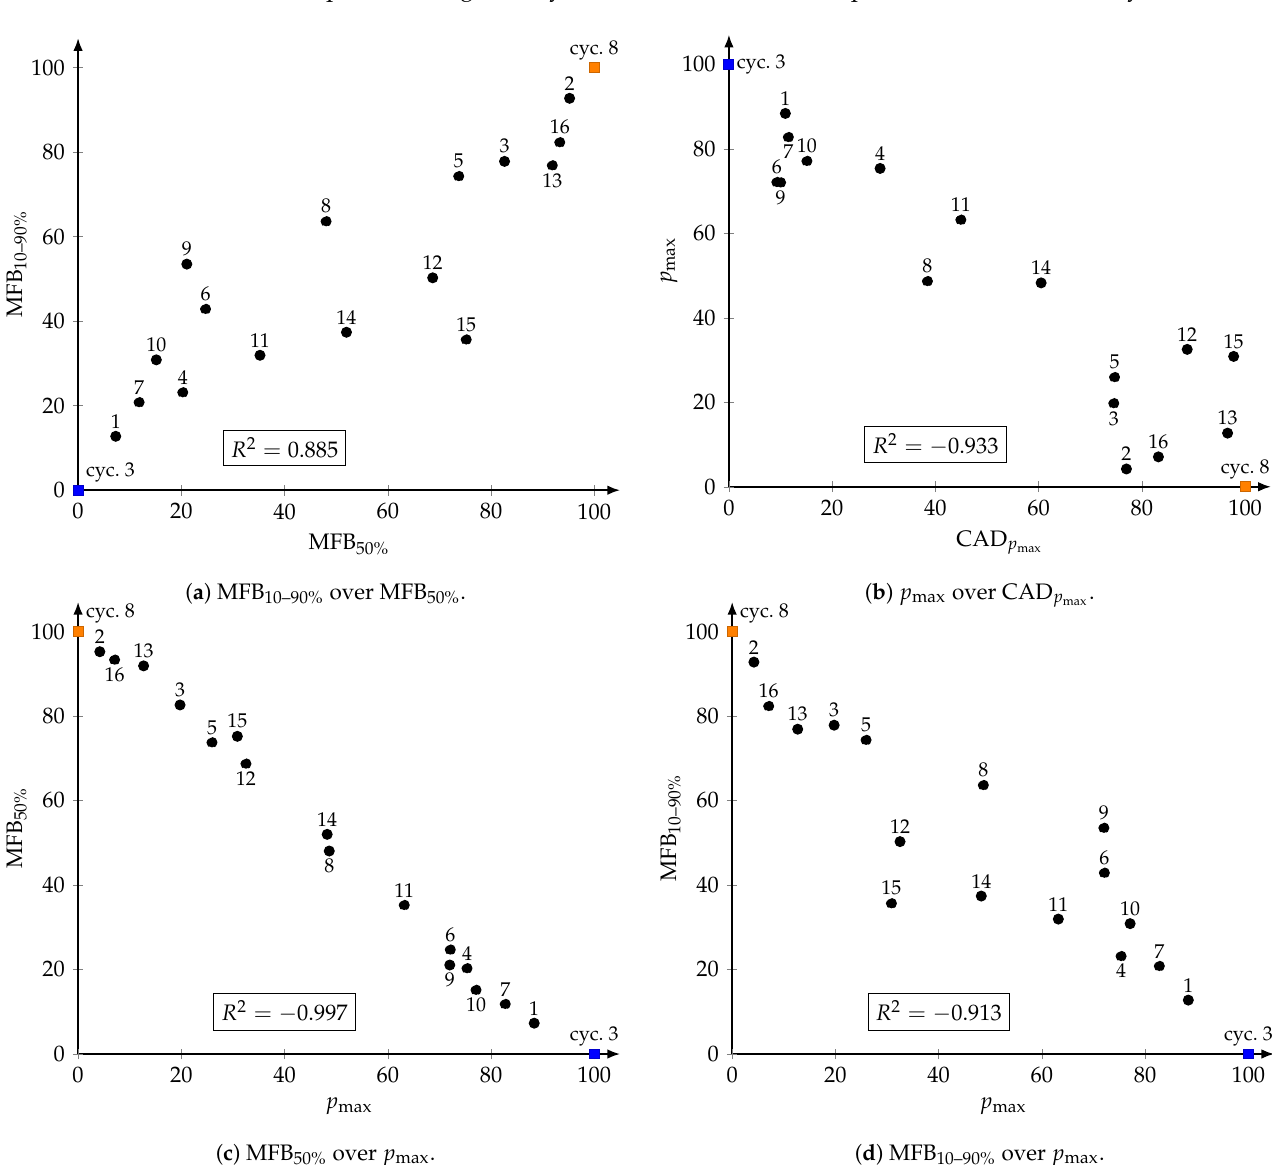
cycle 3 and 8 are plotted as colored square symbols (blue—cycle 3, orange—cycle 8) and denoted as base. Since cycles 3 and 8 represent either the maximum or minimum observed left or right and cycle 8 at upper left or right. Results for the 16 simulated combinations are plotted and generally follow a linear relationship between the two base cycle results.